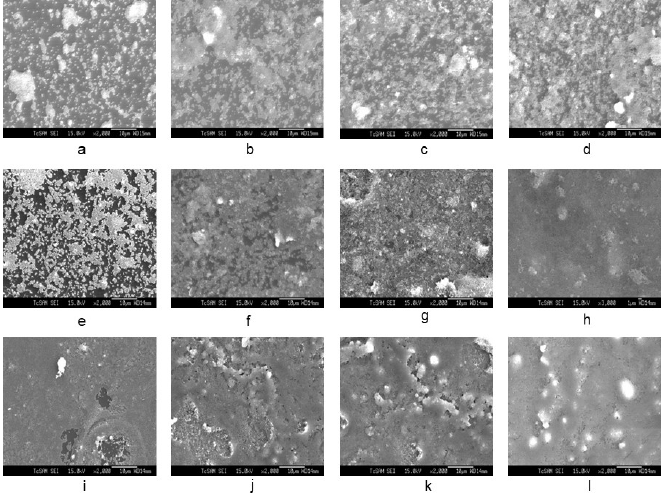
Figure 4. SEM image of seed silicalite-1 on silicon substrate at varying colloidal seed concentrations and number of dip coating ( a – d ). The 1 wt% seed silicalite-1, 1 wt% CTAB and 20 mL ETOH with coating for 1, 3, 5 and 7 times ( e – h ). The 4 wt% seed silicalite-1, 1 wt% CTAB and 20 mL ETOH with coating for 1, 3, 5 and 7 times ( i – l ). The 4 wt% seed silicalite-1 and 20 mL ETOH with coating for 3, 5, 7 and 9 times, respectively.